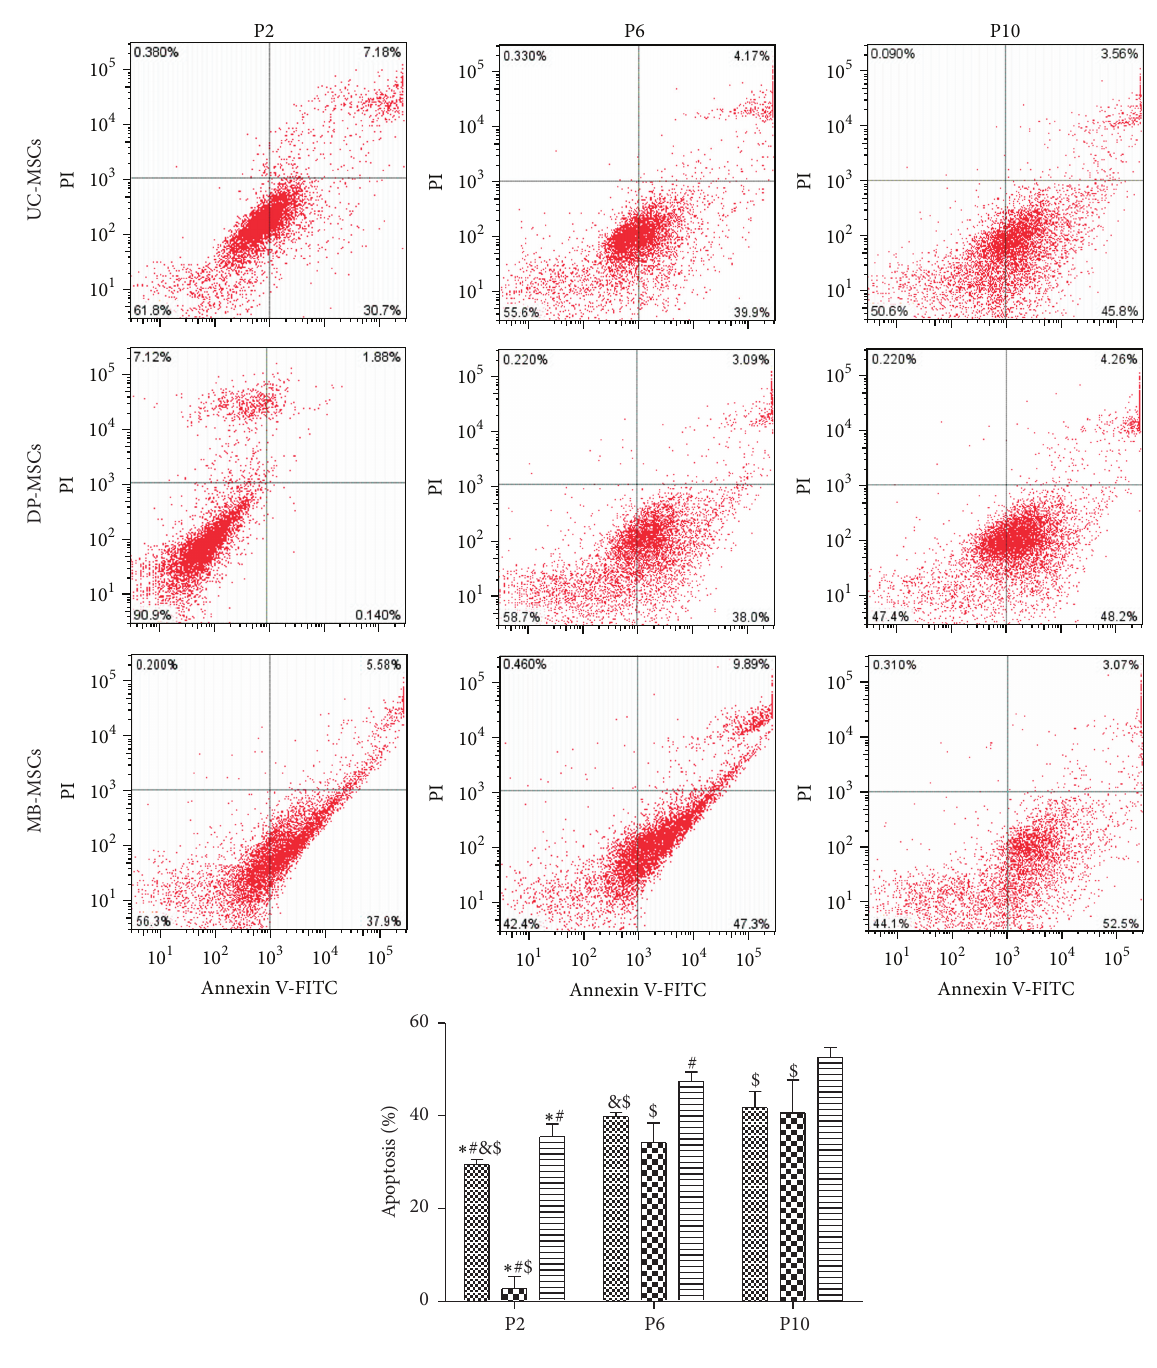
Figure 6: Apoptosis of UC-, DP-, and MB-MSCs. Apoptosis was detected by Annexin V-FITC/PI apoptosis kit and flow cytometry. Each experiment was performed in triplicate: ∗ compared with DP-MSCs at corresponding passage; # compared with MB-MSCs at corresponding passage; & compared with P6 of corresponding MSCs; $ compared with P10 of corresponding MSCs, 𝑝 < 0.05 . UC-MSCs: umbilical cord mesenchymal stem cells; DP-MSCs: dental pulp mesenchymal stem cells; MB-MSCs: menstrual blood mesenchymal stem cells; P: